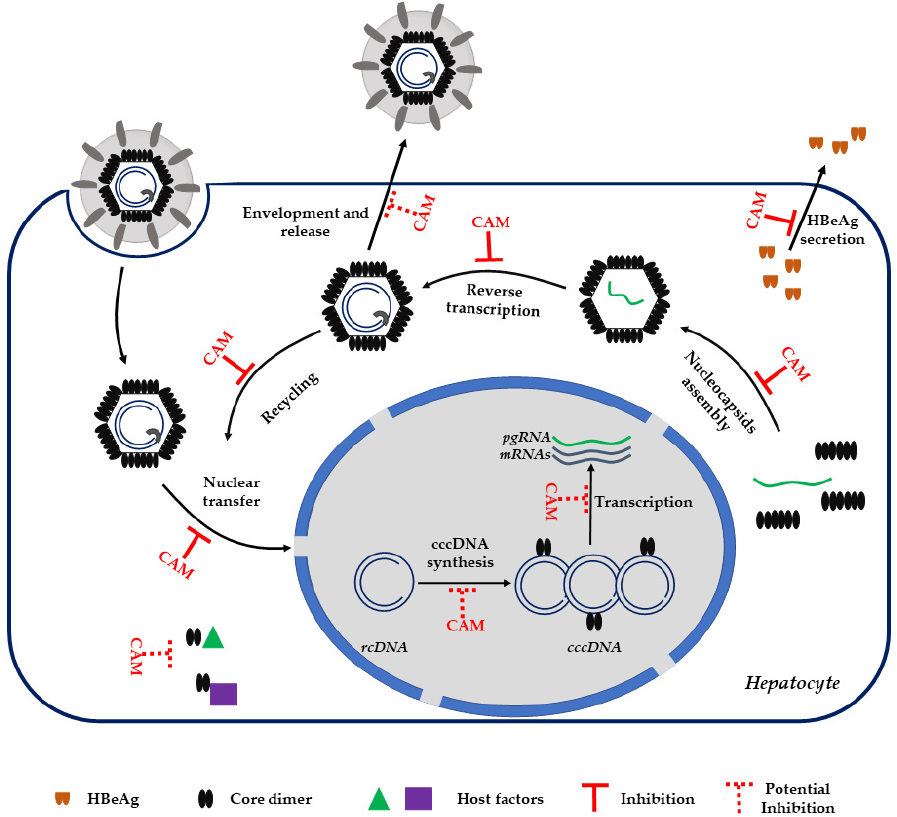
Figure 2. HBV life cycle. The steps regulated by HBV core protein-(HBcAg) and inhibited or potentially inhibited by capsid assembly modulators (CAMs) are indicated. rcDNA: relaxed circular DNA. cccDNA: covalently closed circular DNA. HBeAg: HBV e antigen. pgRNA: pregenomic RNA.